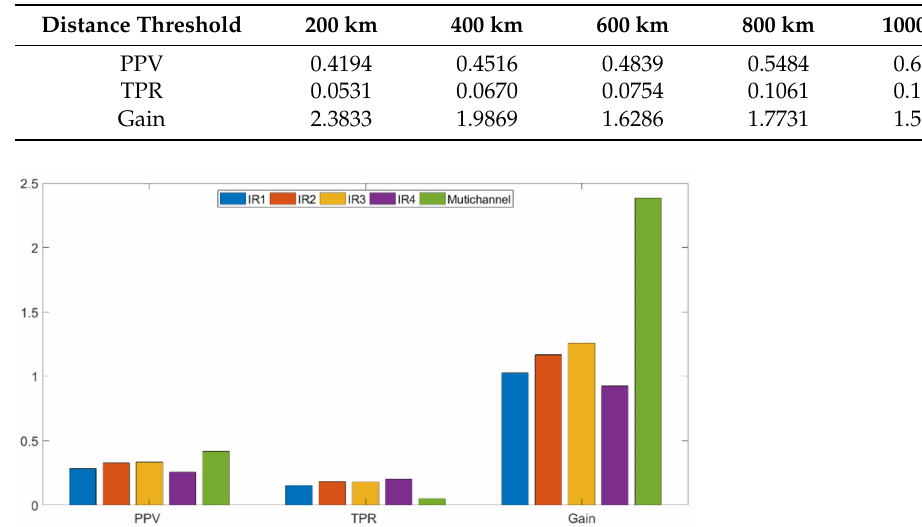
Table 6. Statistical result of multi-channel anomalies.